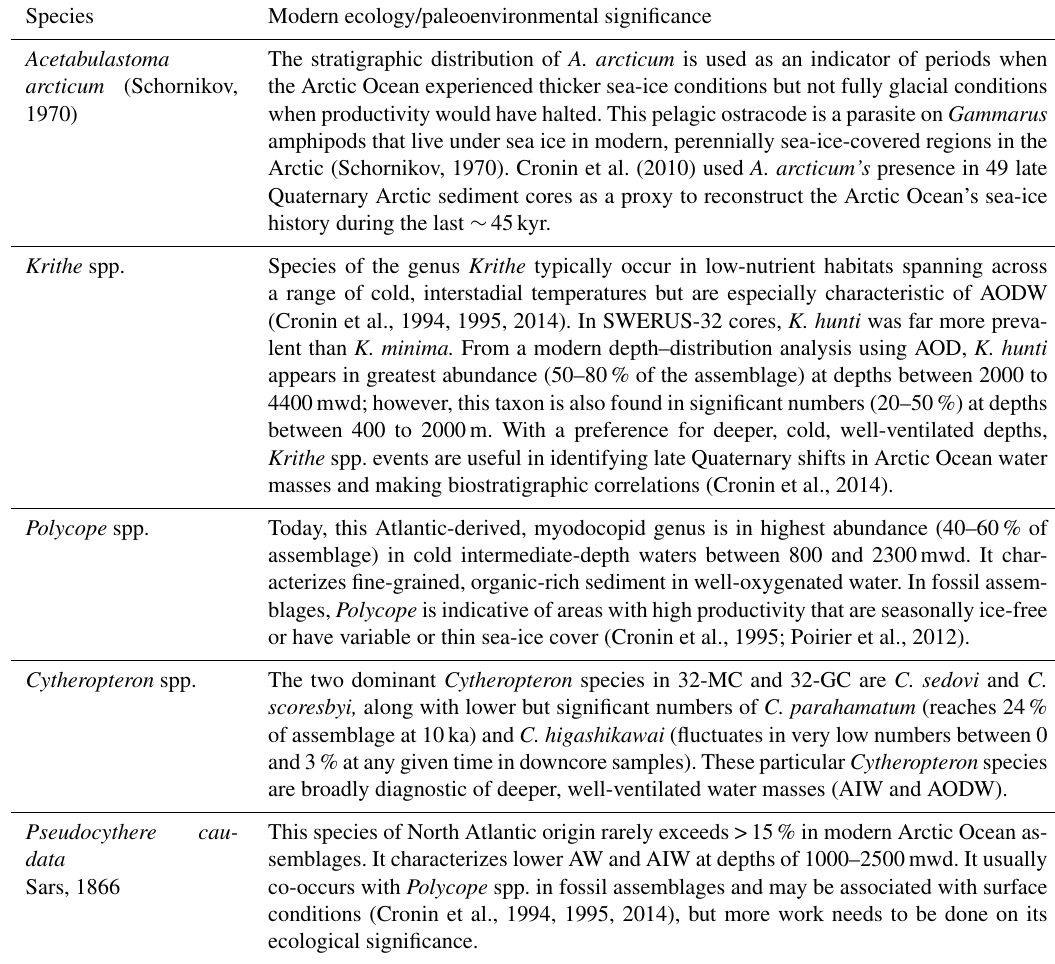
Table S3. Abundances were computed by dividing the num- ber of individual species found in each sample by the total number of specimens found. For 32-MC, using the algorithm for a binomial probability distribution provided by Raup (1991), ranges of uncertainty (“error bars”) were calculated at the 95 % fractile for the relative frequency in each sample to the relative frequency of each species and the total speci- men count of each sample at a given core depth (Supplement Table S4). Faunal densities were high enough to allow com- parisons from sample to sample, and Supplement Table S4 lists the density of ostracode specimens per gram of dry sed- iment, which averaged > 125 shells per gram sediment.